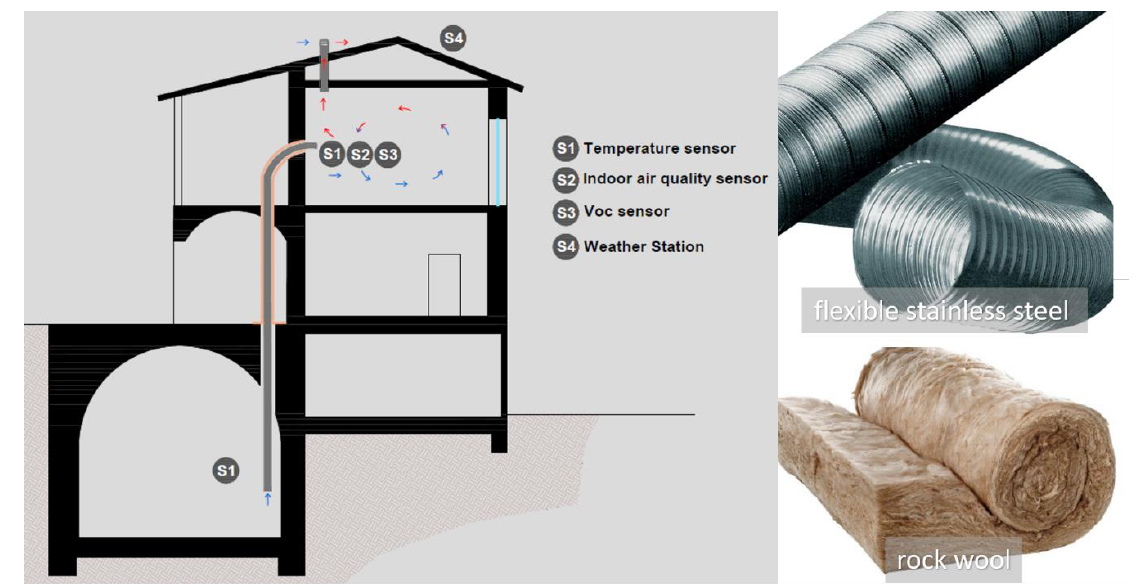
Figure 4. Scheme of the duct route through the floors (basement–ground–first floors). The materials used are steel and rock wool.